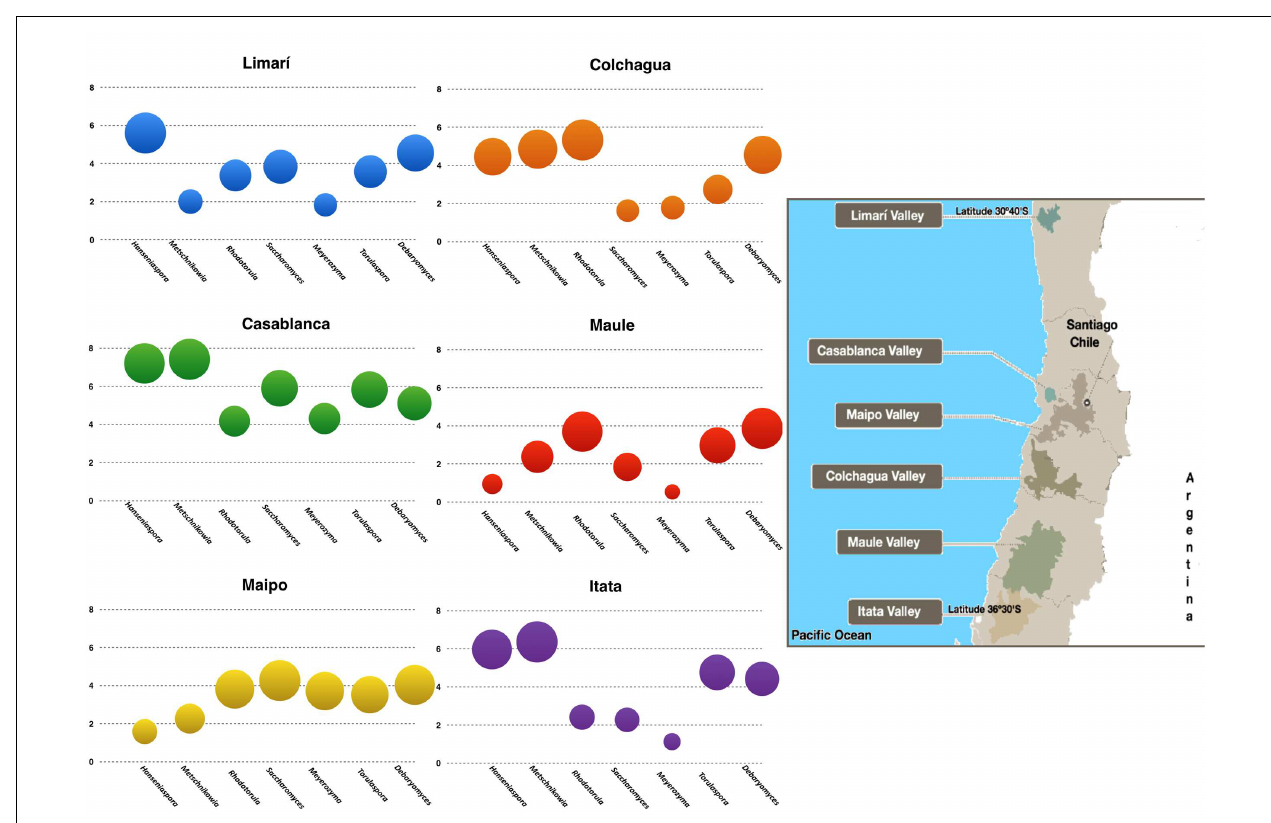
FIGURE 1 | Microbial terroir in different Chilean Valleys. The graphics represent the load of the yeast of enological interest as were quantified by qPCR in the different valleys examined (log 10 scale). The insert in the right corresponds to a map showing the location of the valleys.